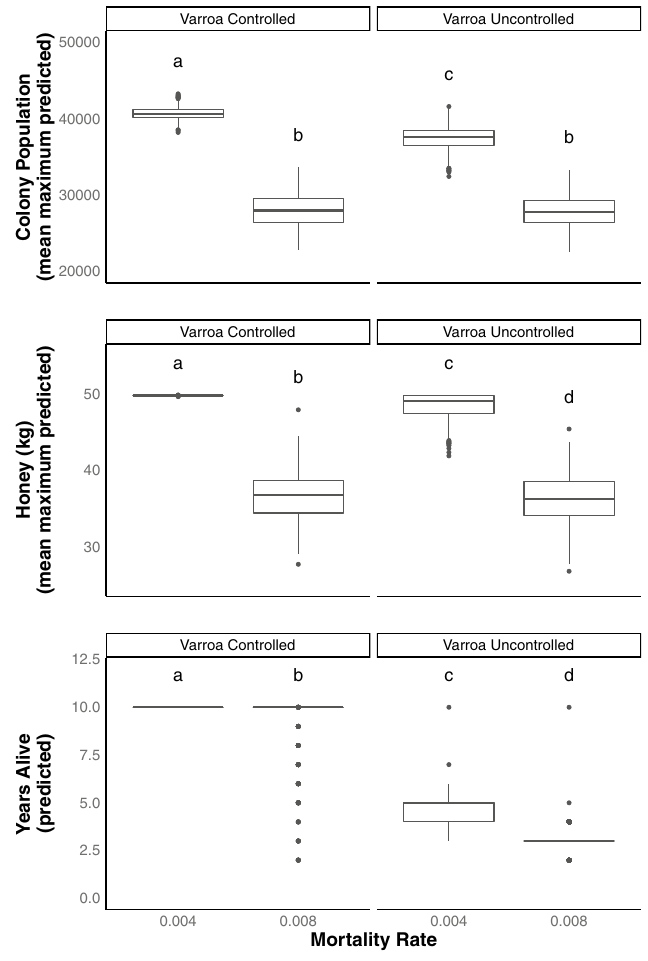
Figure 5. BEEHAVE modelling results for different in-hive mortality rates and Varroa control regimes. Each box represents 1000 replicates. Daily worker bee in-hive mortality rate was left to either the default setting of 0.004 (mid twentieth century estimated lifespan) or increased to 0.008 (2010–2019 estimated lifespan). Models employing each mortality rate were repeated with the adjustment of Varroa treatment. All other model parameters were left to default setting. Letters indicate pairwise comparisons using a Wilcoxon Rank Sum test with the Benjamini–Hochberg procedure for controlling false discovery rate.